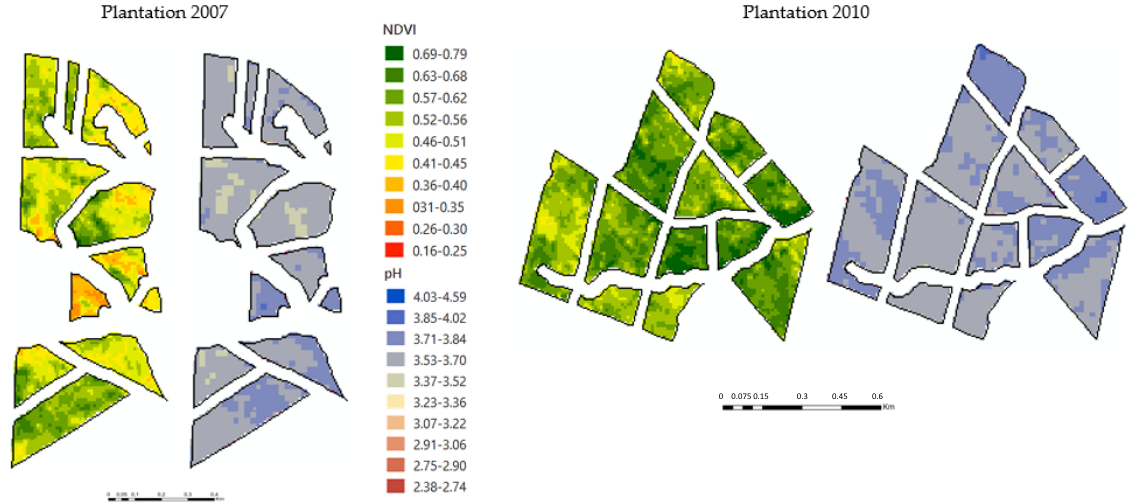
Figure 13. NDVI and pH model maps, 2017